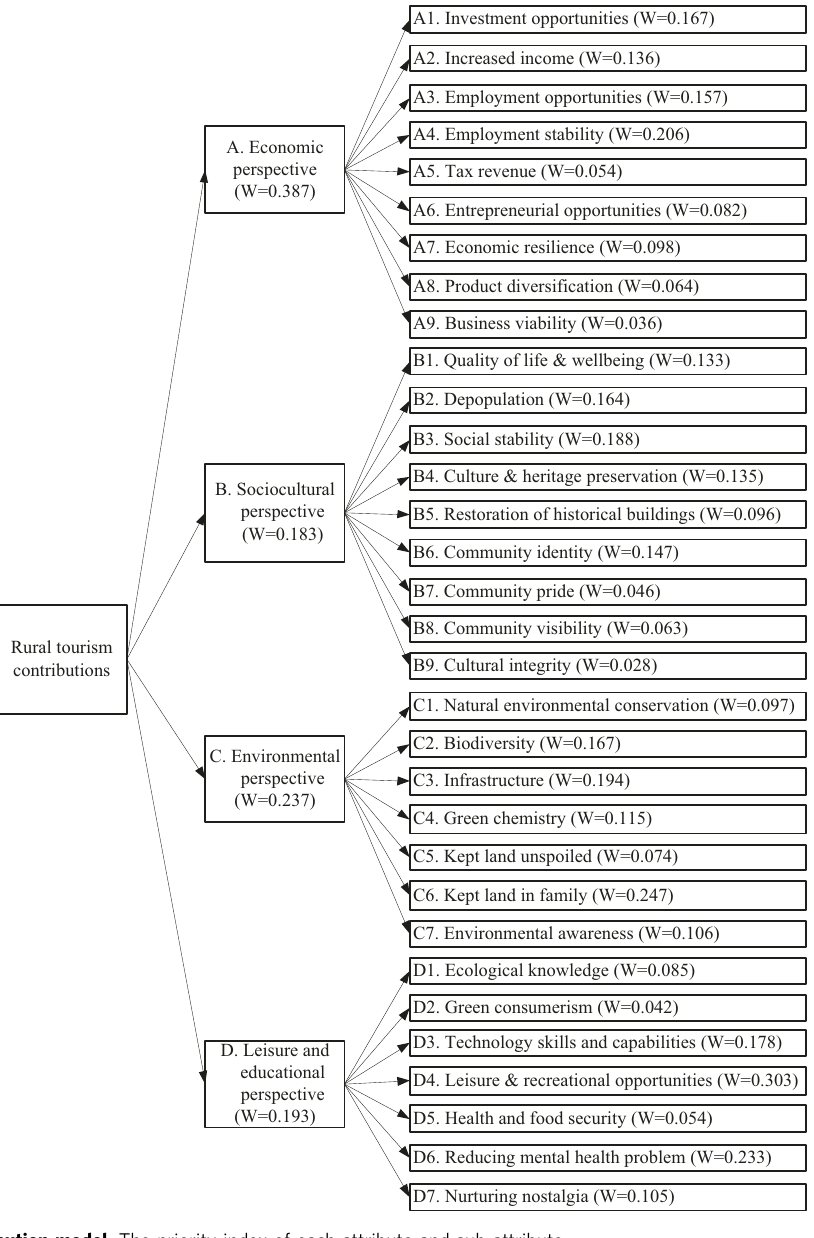
Fig. 2 Rural tourism contribution model. The priority index of each attribute and